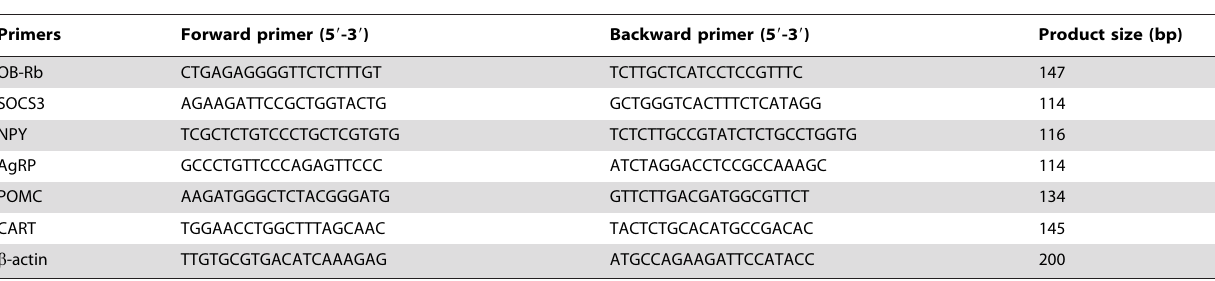
Table 1. Gene-specific primers used for Real-Time